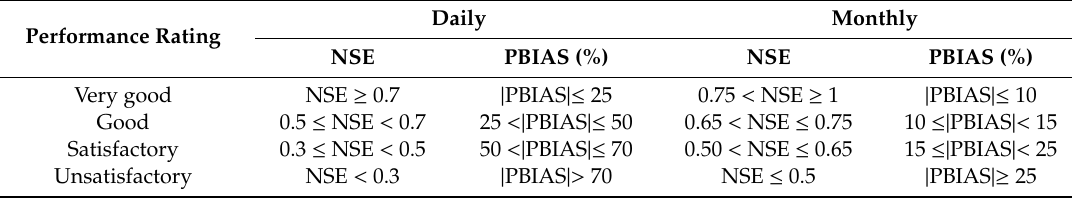
Table 1. Evaluation model criteria for daily / monthly time